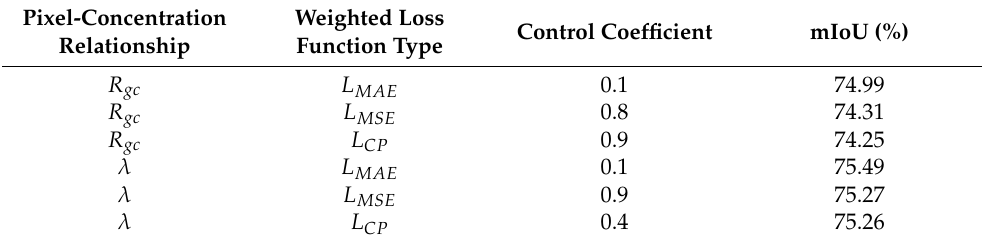
Table 2. Segmentation results of the pixel-concentration relationship, the type of weighted loss